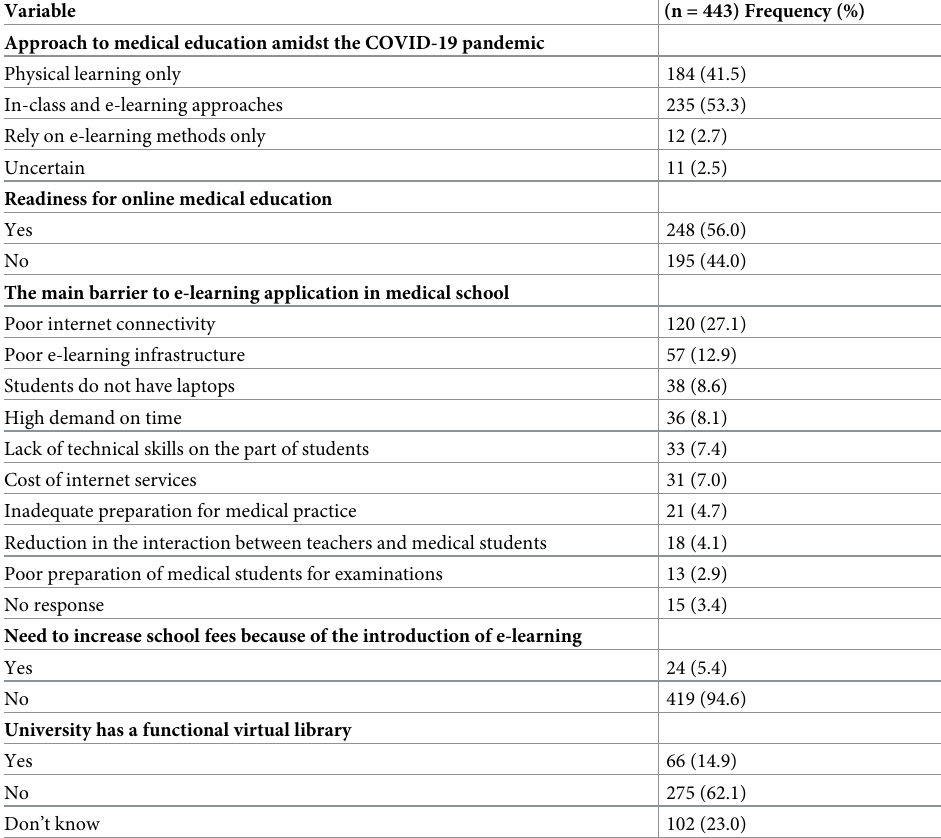
Table 4. Barriers for online medical education among the respondents.